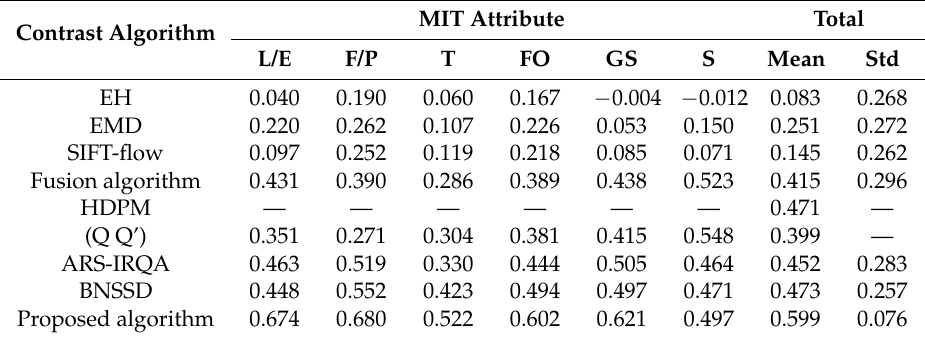
Table 4. Classification comparing Kendall rank correlation coefficient (KRCC) of multiple evaluation methods in database MIT.